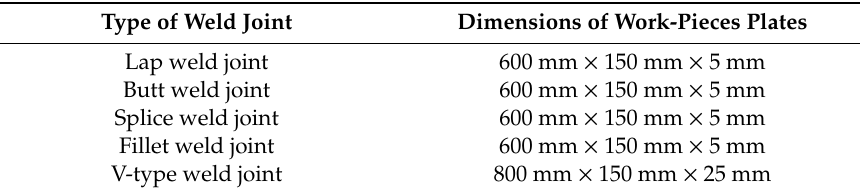
Table 5. New weld joint parameters.